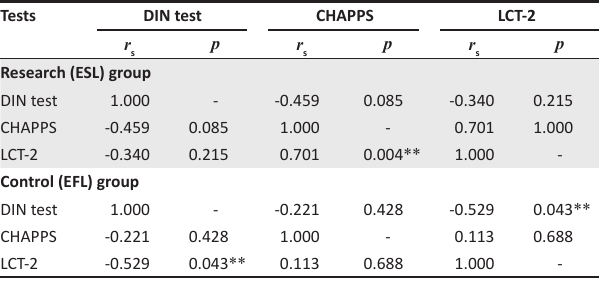
FIGURE 1: The number of participants in the English second language and English first language groups who passed or failed the digits-in-noise test according to their signal-to-noise ratio. TABLE 3: Results of the Spearman rank correlation to determine the strength of association between the digits-in-noise test, children’s auditory processing performance scale and listening comprehension test